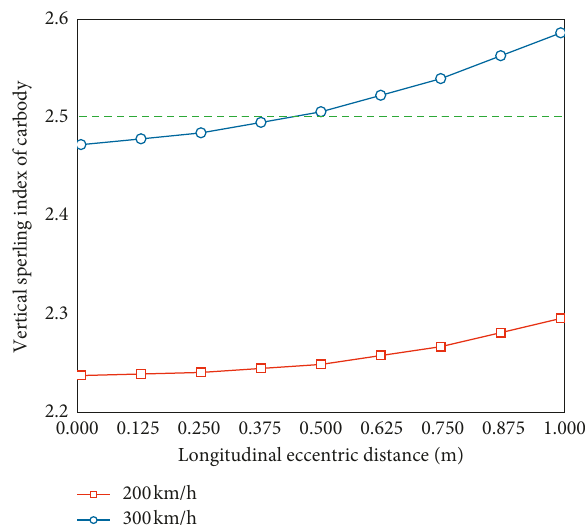
Figure 8: Influence of UCE longitudinal eccentricity on the vertical Sperling index.